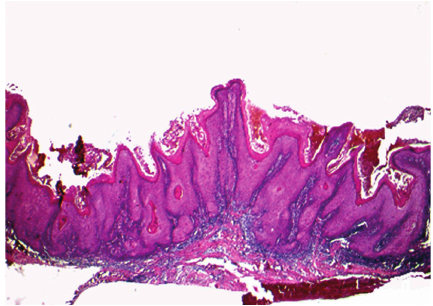
Figure 2: Histologic section showing stratified squamous epithe- lium with intense hyperplasia and hyperparakeratosis (hematoxylin and eosin stain, original magnification × 25).